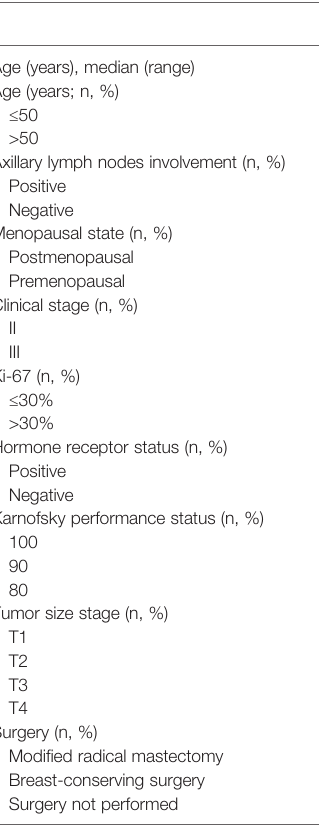
TABLE 1 | Baseline characteristics of patients. Age (years), median